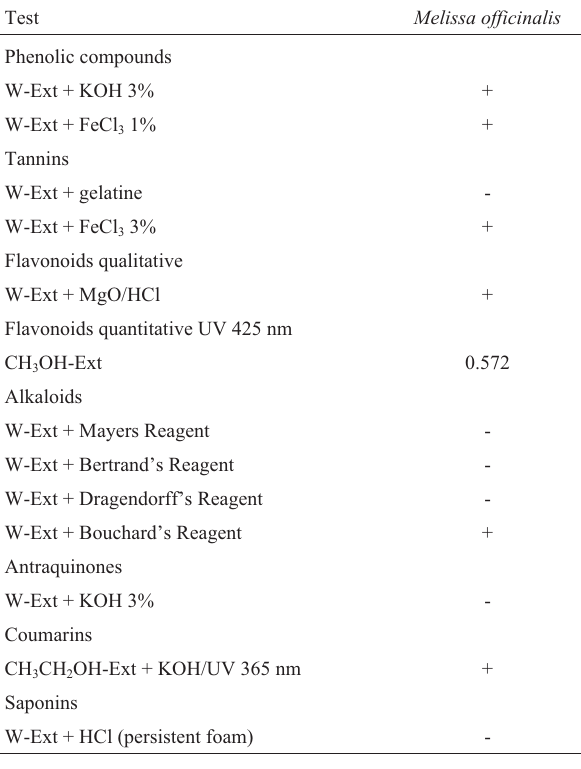
Table 1 - Phytochemical screening.